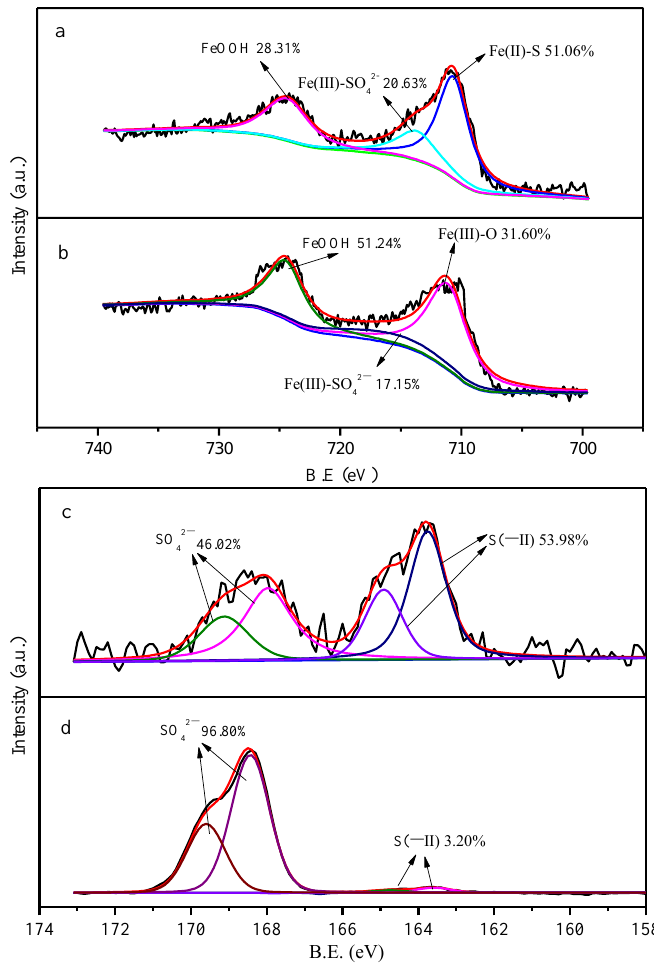
Figure 4. XPS spectra before and after reaction for TC Removal by CMC-FeS. Fe 2p before ( a ) and after ( b ); S 2p before ( c ) and ( d ).